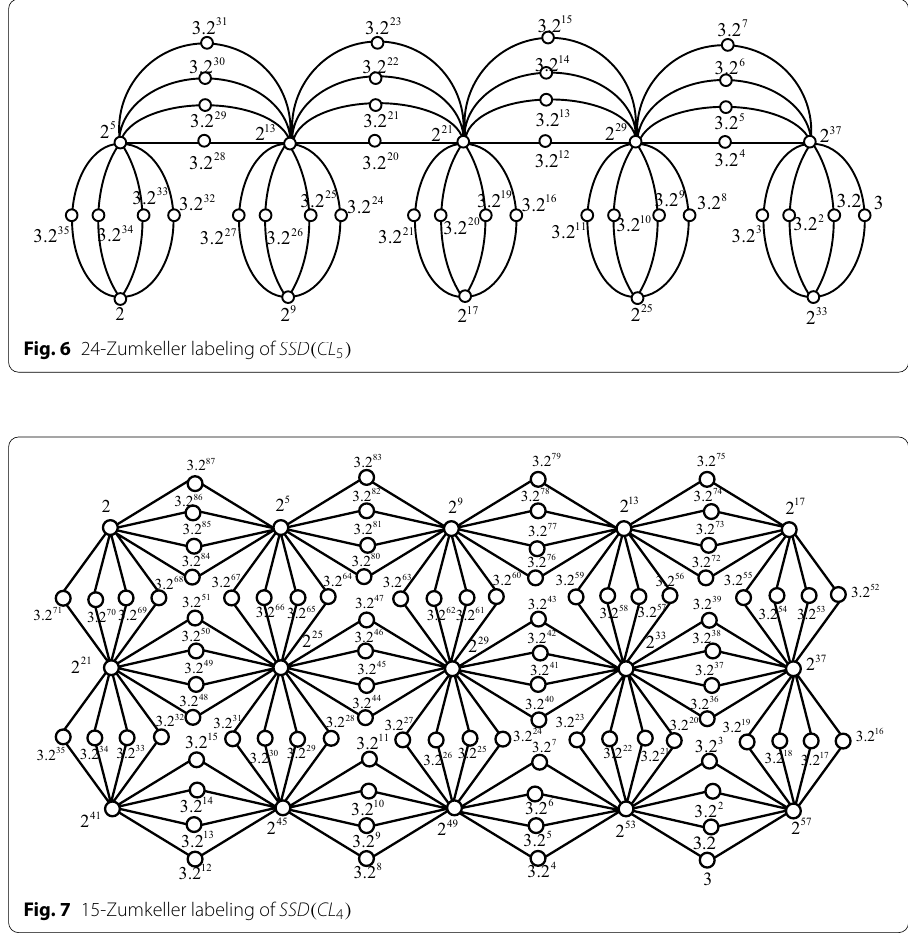
( CL 4 ) and its 15- Zum-